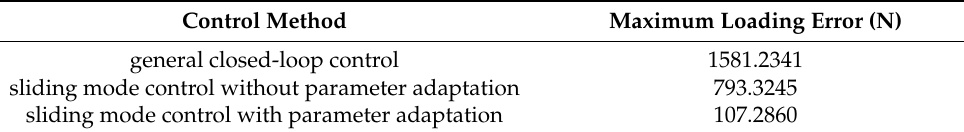
Figure 16. Loading error comparison under different control methods. Table 3. System loading error comparison.